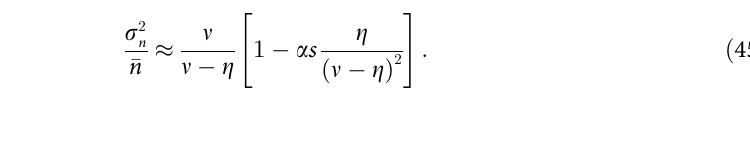
Fig 7. The phase plane for the dynamics of TE load. The dynamics of the mean ( n ) and variance ( s 2 predicted by the moment equations, Eqs (41) and (42)), can be understood through phase plane analysis. The red and green curves are the nullclines for the mean and variance, respectively, with intersection corresponding to the steady state (open circle). The blue trajectories show the dynamics of equilibration. A: Mean loads similar to Mimulus . Parameters: ν = 2.5, m = 5 × 10 5 , η 0 = 20 and η = 3 with no selection ( α = 0, s = 0). B: Mean loads similar to Drosophila . Parameters: ν = 0.1, m = 5000, η 0 = 1 and η = 0.1. Dotted nullclines: no selection. Dashed: s = 10 − 4 , α = 5. Solid: s = 10 − 4 , α = 20. Note that increased selection on TE load (gray arrow) decreases the index of dispersion ( Fano ½ n � ).